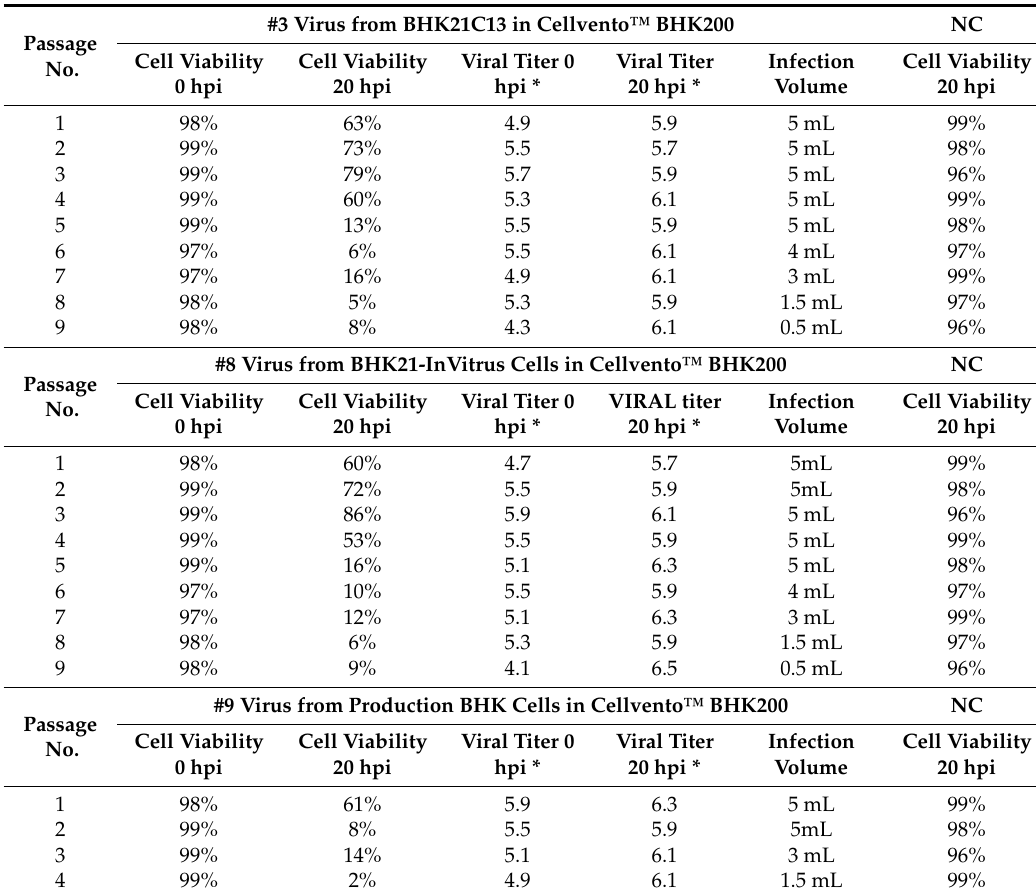
Table 1. Decrease of cell viability and the required infection volume during serial passaging of Asia-1 isolates with different original cell adaption background on